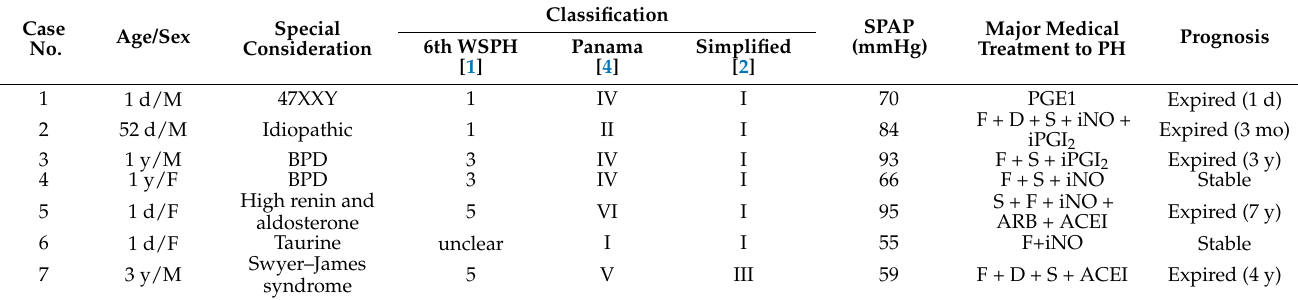
Table 1. Clinical and imaging characteristics of the patients with unique PH.